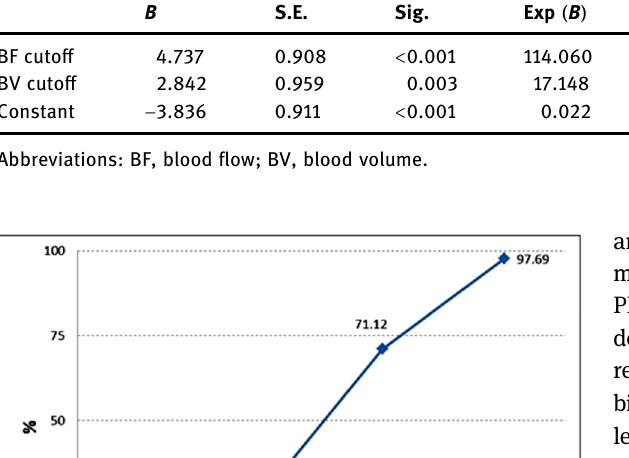
Table 4: Logistic regression for estimating the probability occurrence of PDAC B